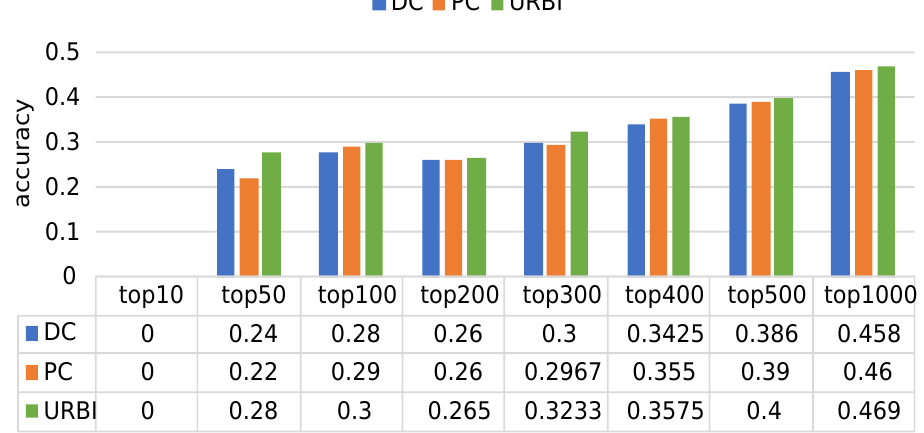
Figure 13. This figure depicts the experimental results of dataset No.13, which contains 9174 book nodes.